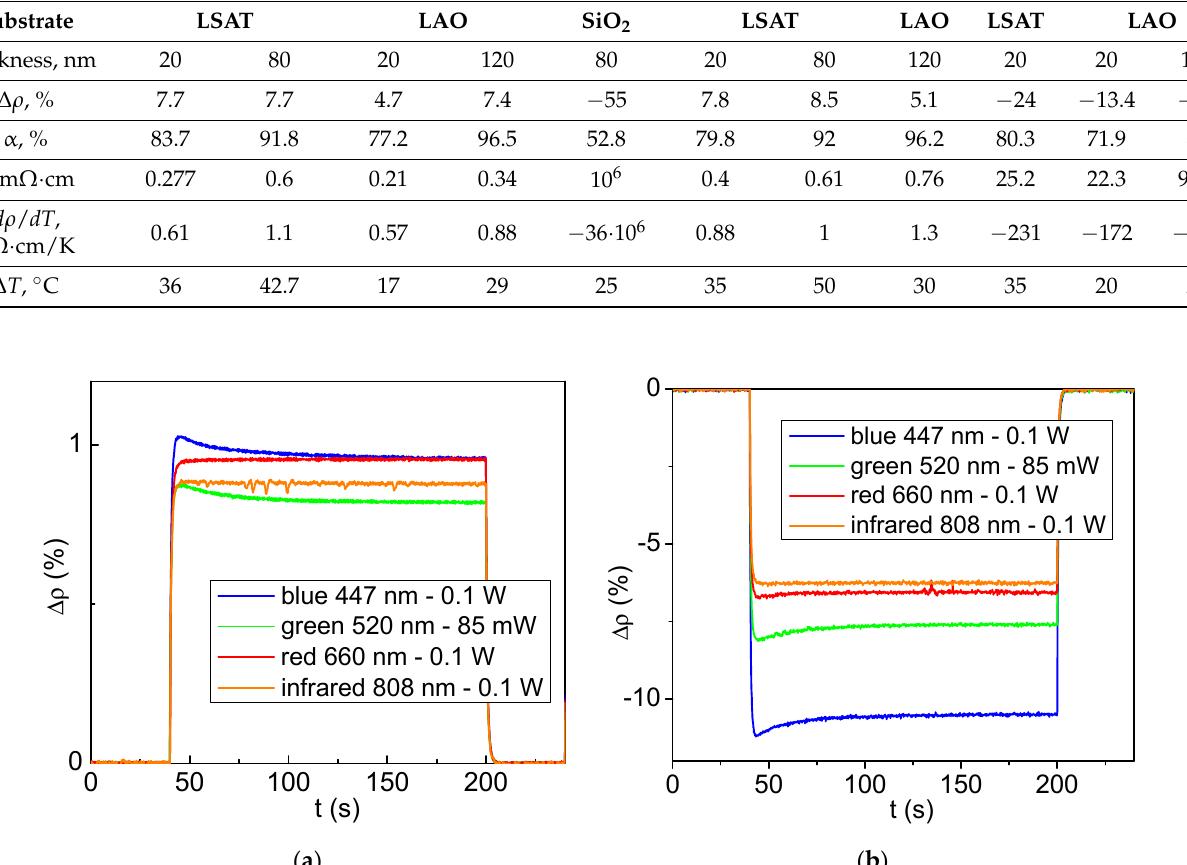
Figure A5. Percentage change of the resistivity for NNO films on ( a ) LSAT and ( b ) SiO 2 substrates at fixed temperature T = 26 °C and long-term illumination by different lasers at optical power 0.1 W (except the green laser, which maximal power is 85 mW).